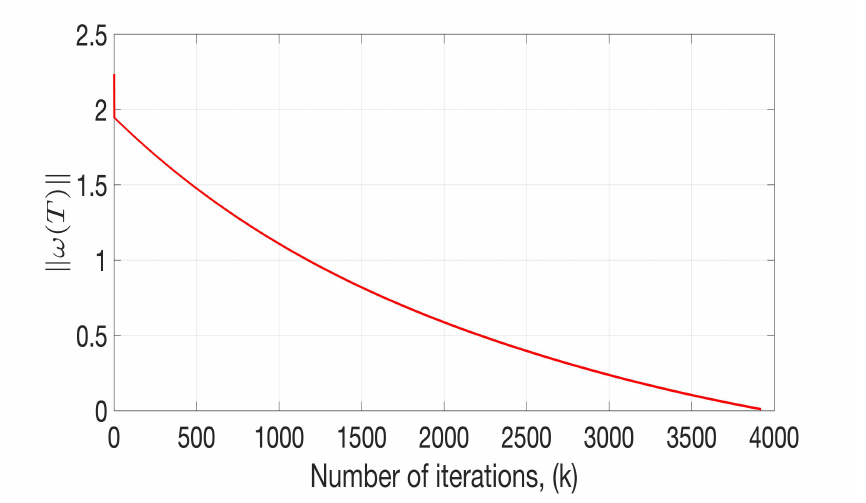
Figure 7. Recurrent evolution of the norm of the weights at the time moment T defined by the Kiefer–Wolfowitz